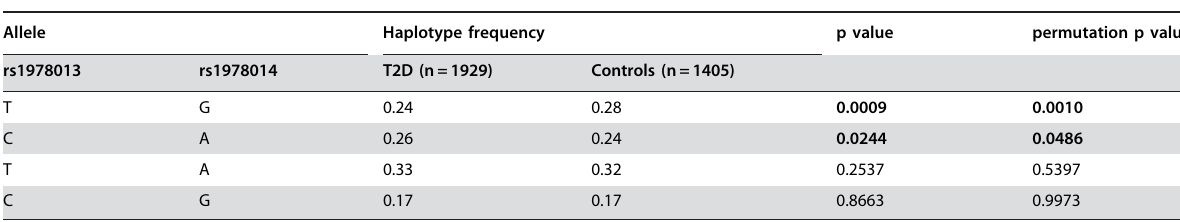
Legend to Table 3. * To correct for multiple testing, 10000 permutations were done. doi:10.1371/journal.pone.0001090.t003 ..